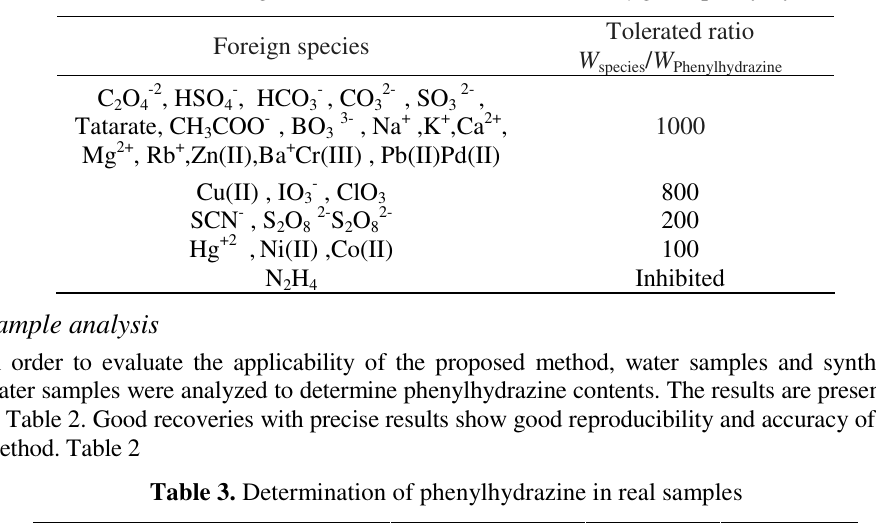
Table 2. Effect of foreign ions on the determination of 0.10 µg/mL phenylhydrazine